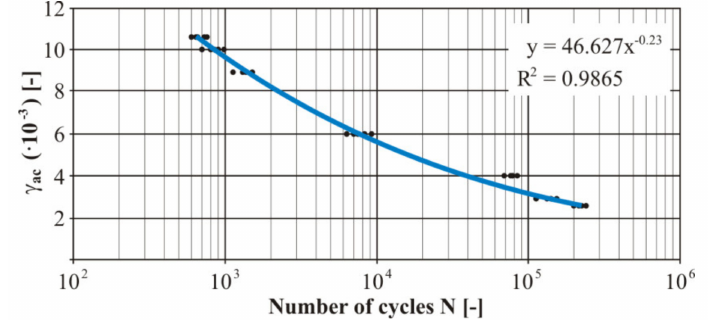
Figure 25. The final Manson − Co ffi n fatigue curve of the basic material EN AW 6063 under the torsion load.